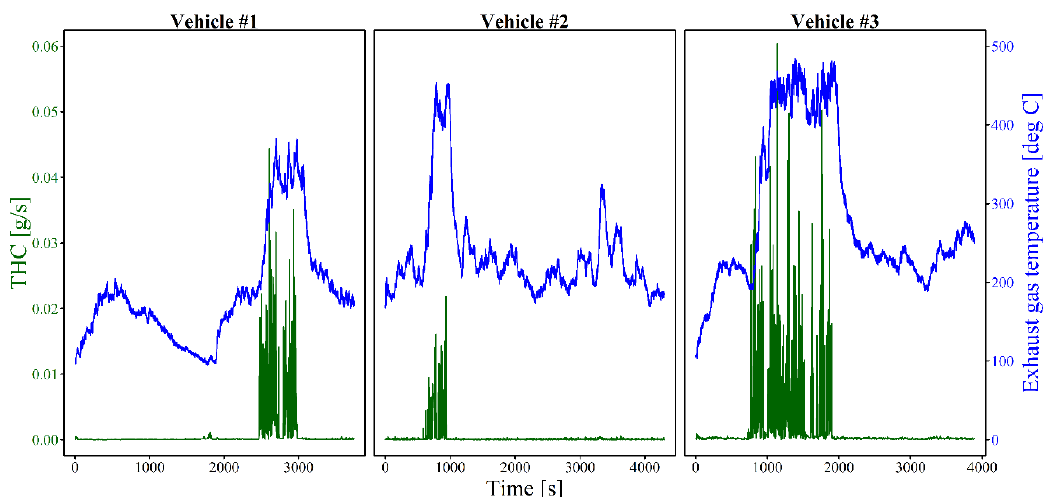
Figure 6. Total hydrocarbons (THC) and exhaust gas temperature overtime for three indicative diesel particulate filter (DPF) regeneration events.